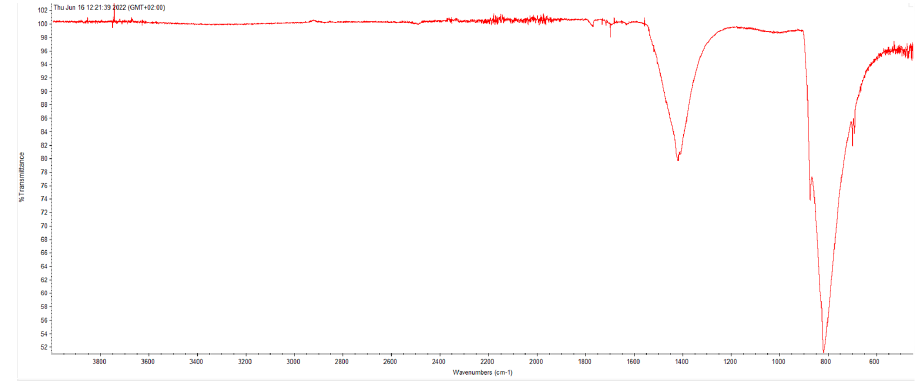
Figure 11. IR spectrum of the same sample.